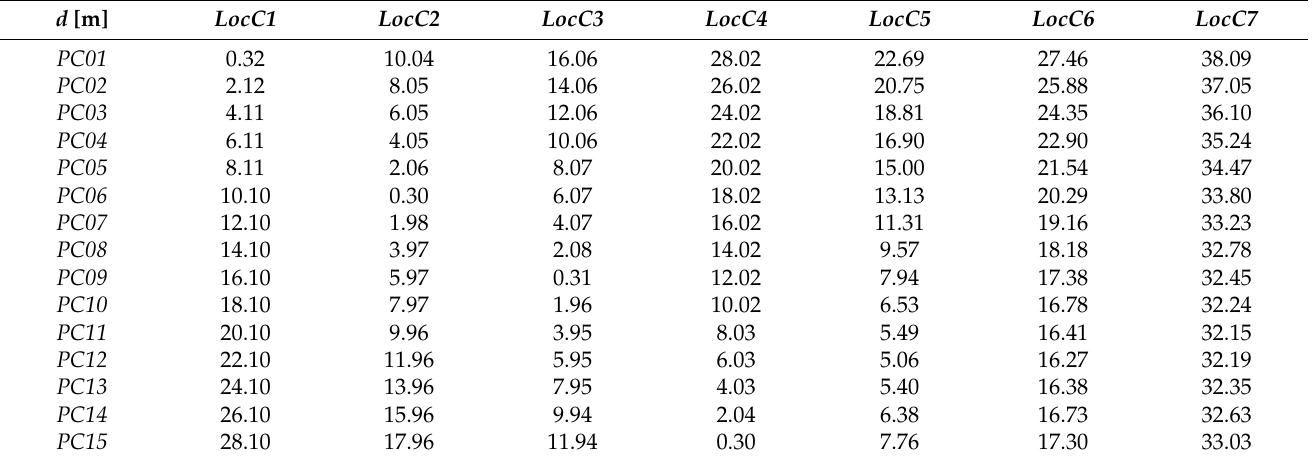
Table 5. The distances between the projections on the floor plane of the object positions and locator